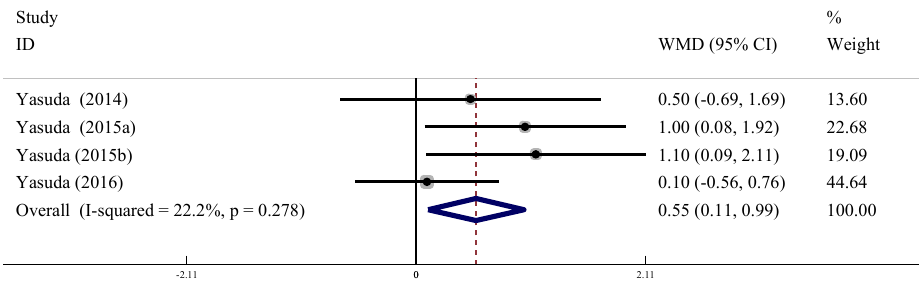
Figure 12. Meta-analysis of the effect of LL-BFR training on CAVI of the older adults.